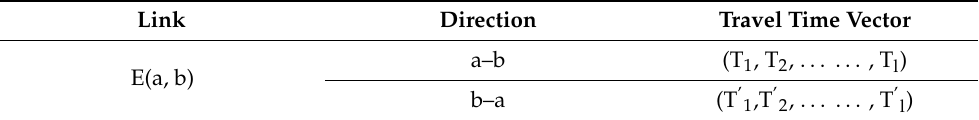
Table 3. Travel time vector of one link E(a, b) by time interval.